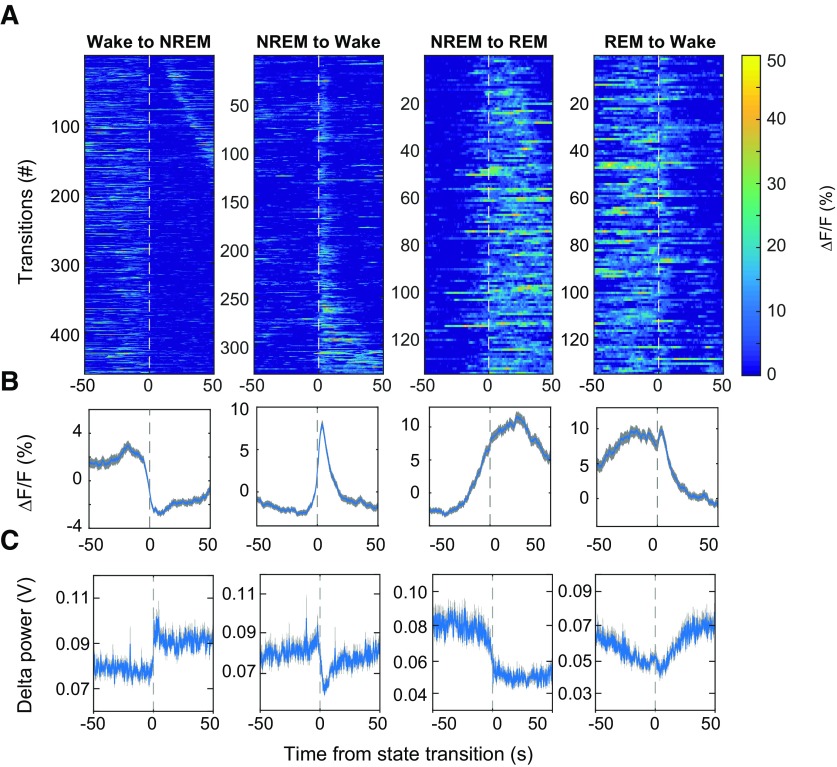
VTA-GABAergic population dynamics around arousal state transitions. A, Heatmaps of fluorescence intensity aligned to arousal state transitions (wake to NREM, n = 459; NREM to wake, n = 329; NREM to REM, n = 135; REM to wake, n = 135). Trials are sorted by the duration of the second state (shortest, top; longest, bottom). B, Average responses from all the transitions expressed as mean (blue trace) ± SEM (gray shading). C, EEG δ (1–4.5 Hz) power from all the transitions.